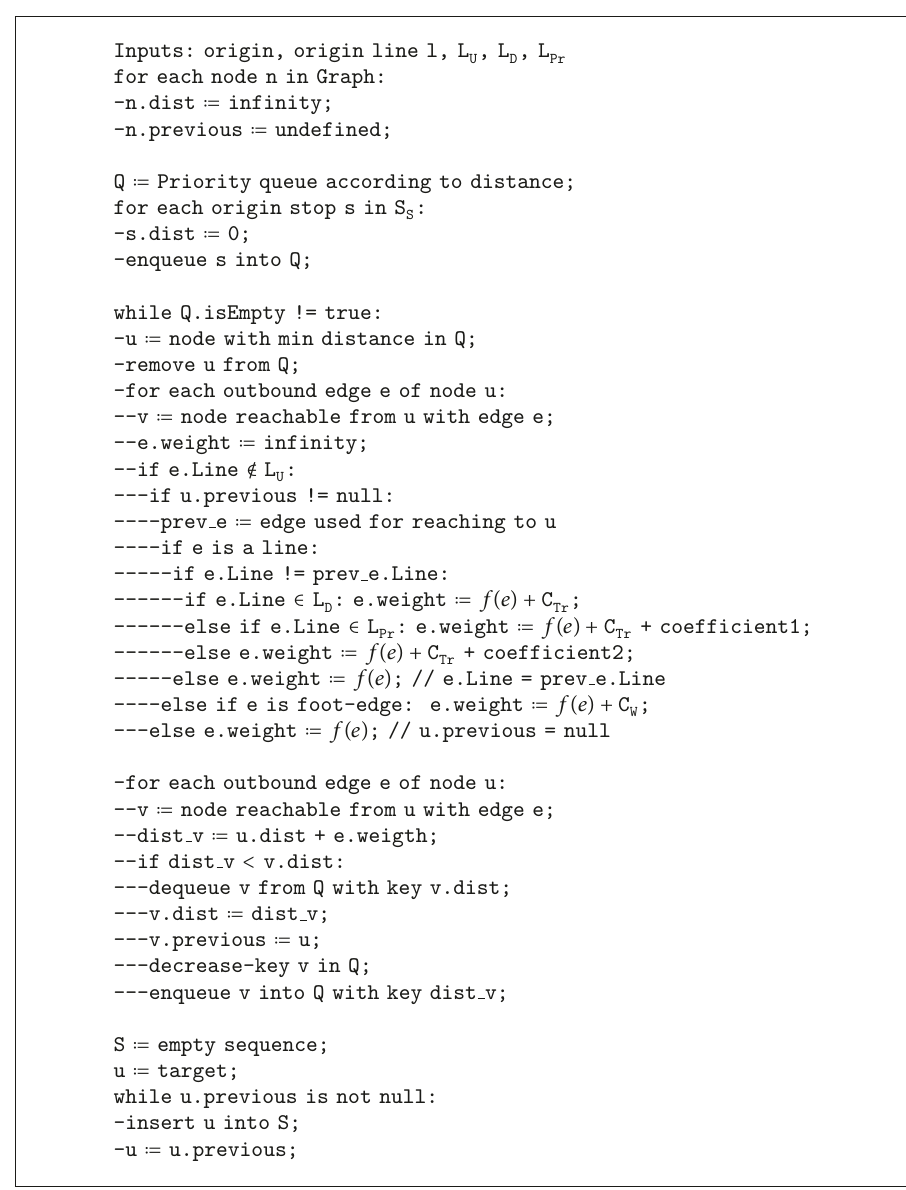
Algorithm 3: Finding routes containing 𝑛